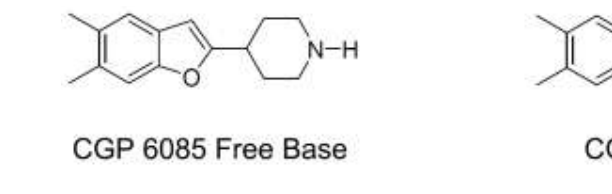
Figure 2. Free base and salt form of CGP6085.